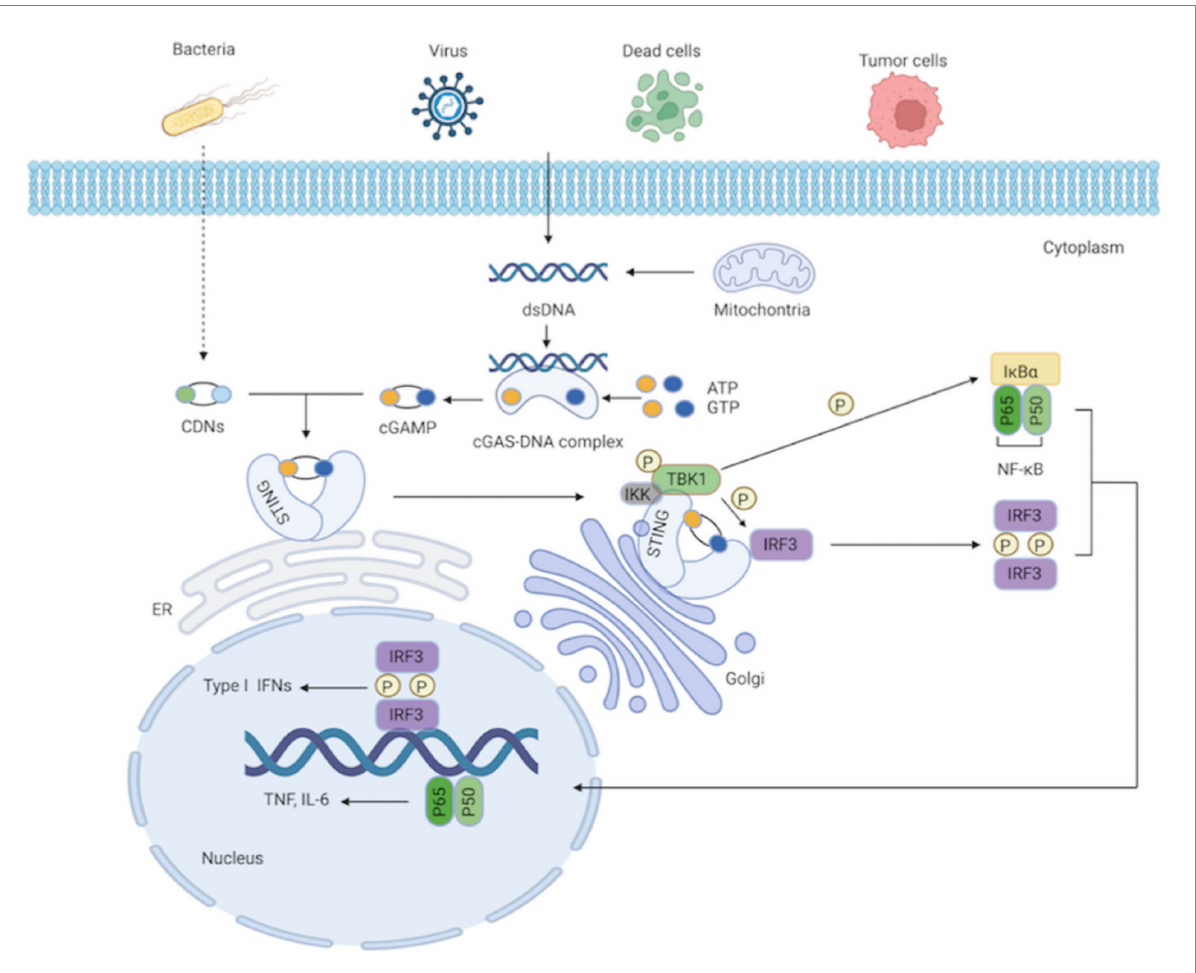
FIGURE 1 cGAS-STING signaling pathway. The cytosolic DNA sensor cGAS senses exogenous DNA from dying cells, tumor cells, viruses, bacteria, as well as endogenous DNA leaking from mitochondria. The synthesis of cGAMP by activated cGAS employing ATP and GTP as substrates, and cGAMP then activates STING by functioning as a second messenger. What’ more, the CDNs produced by bacteria can instantly activate STING. IKK and TBK1 are then recruited and activated by STING as it moves from the ER to the Golgi apparatus. IRF3 is further recruited and phosphorylated by TBK1. Afterward, phosphorylated IRF3 forms dimers, translocates to the nucleus, and functions synergistically with NF- κ B, thereby resulting in the production of IFN-I and pro-inflammatory